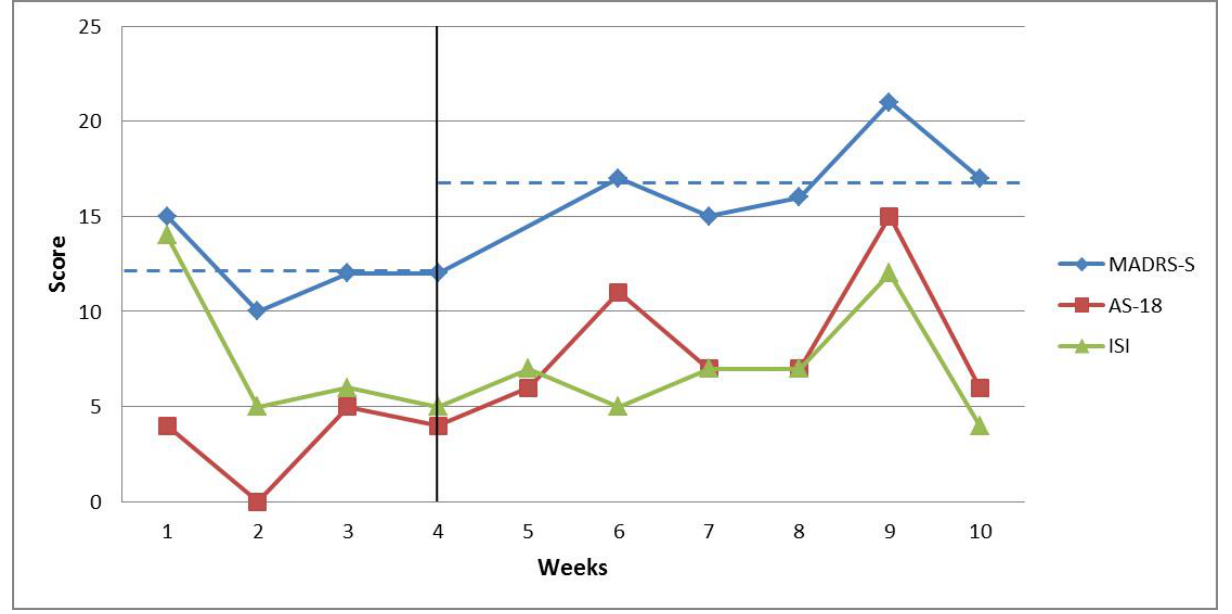
Figure 4. Weekly ratings of depressive symptoms (MADRS-S, maximum score is 54 points), symptoms of (hypo)mania (AS-18, maximum score for mania section is 36), and insomnia (ISI, maximum score is 28 points) for patient 3. The vertical line marks the start of the intervention period. Dashed blue lines indicate the mean level of depressive symptoms (MADRS-S) during the baseline period and the treatment phase.